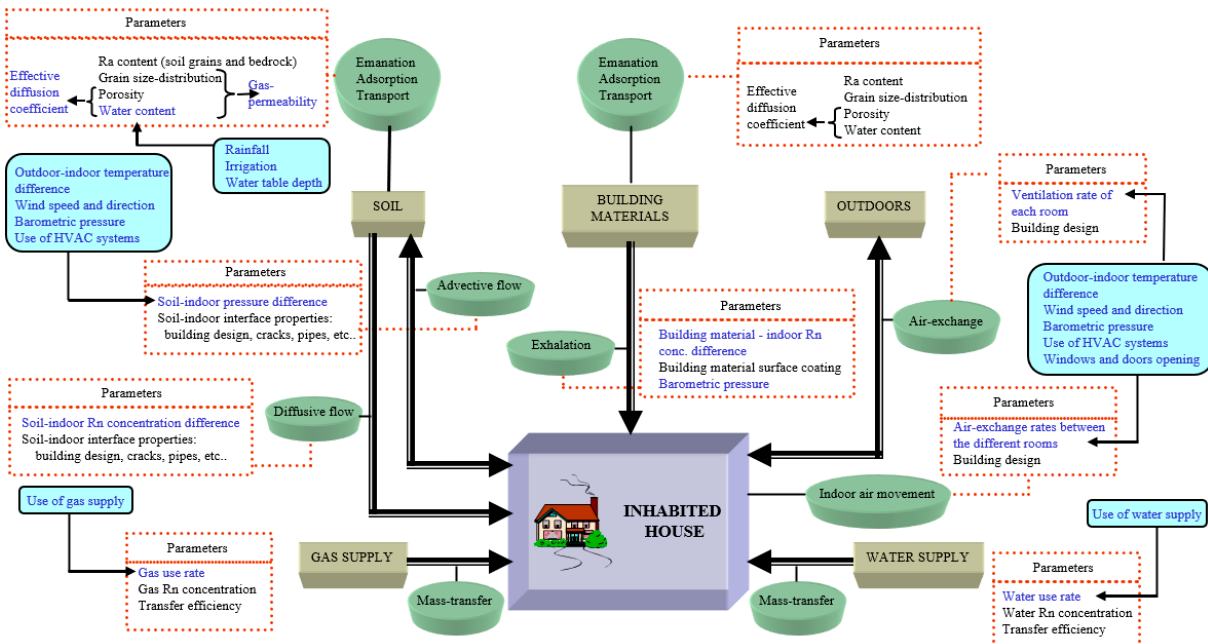
Figure 3. Diagram of the sources (brown square boxes), processes (green round boxes), and parameters that a global dynamic radon model must consider. The time-dependent parameters are in blue. Figure by Font L, available at https://icnts2008.bo.infn.it (accessed on 15 December 2021). Reprinted with permission from Lluis Font (2008). [20].